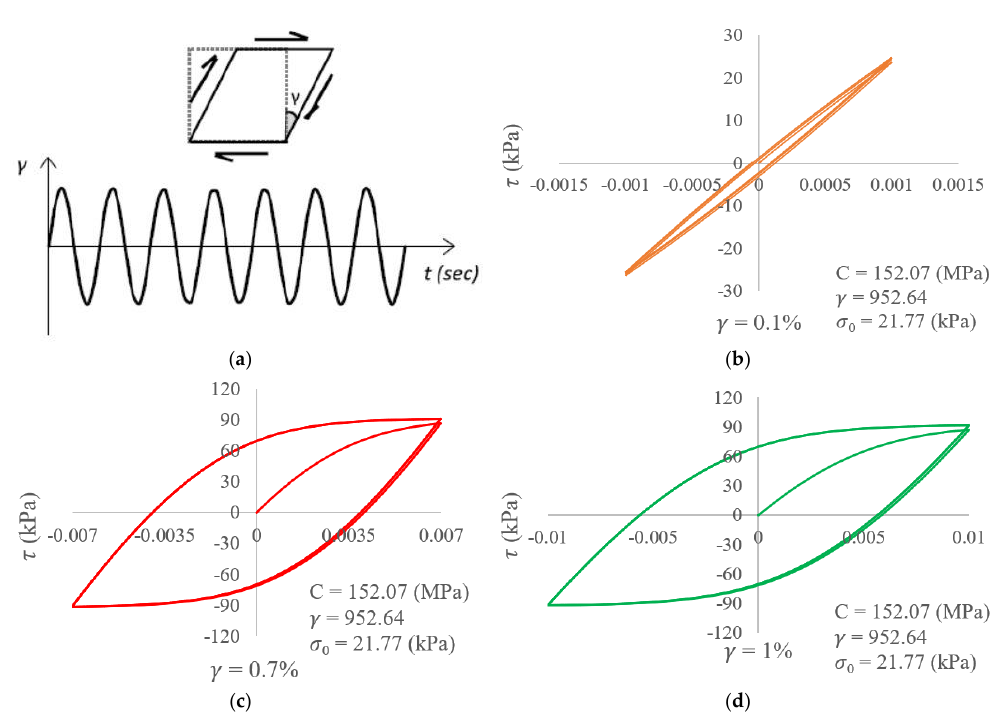
Figure 5. Hysteresis loops of a cyclic simple shear test at different strain levels: ( a ) engineering shear strain vs. time, ( b ) γ = 0.001, ( c ) γ = 0.007, ( d ) γ = 0.01.